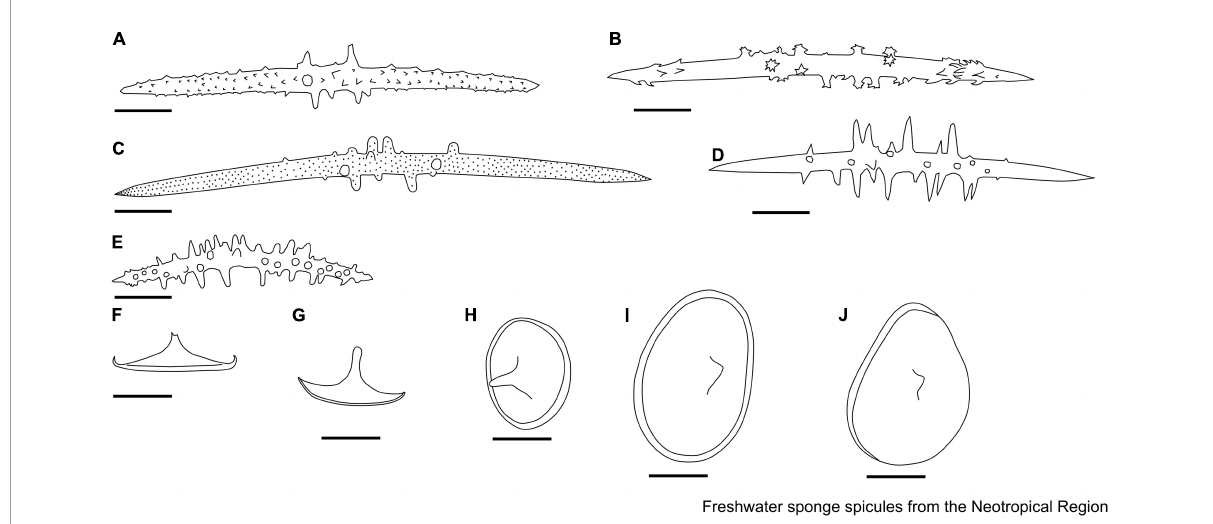
FIGURE11 (A–J) Drulia Gray, 1867. Microscleres. (A) Acanthoxeas, covered with spines, with conical spines in the center of the spicule; (B) acanthoxeas with spines flat-ended and harpoon-shaped at extremities; (C) microspined oxea, a few larger spines with rounded extremities irregularly grouped near the central part of spicules; (D) acanthoxeas, with conical spines in the center of the spicule, spines with lanceolate tips; (E) acanthoxeas are covered almost to their extremities with large, straight, conical spines. Gemmuloscleres. (F–J) Parmuliform. Scale: 10 µ m.